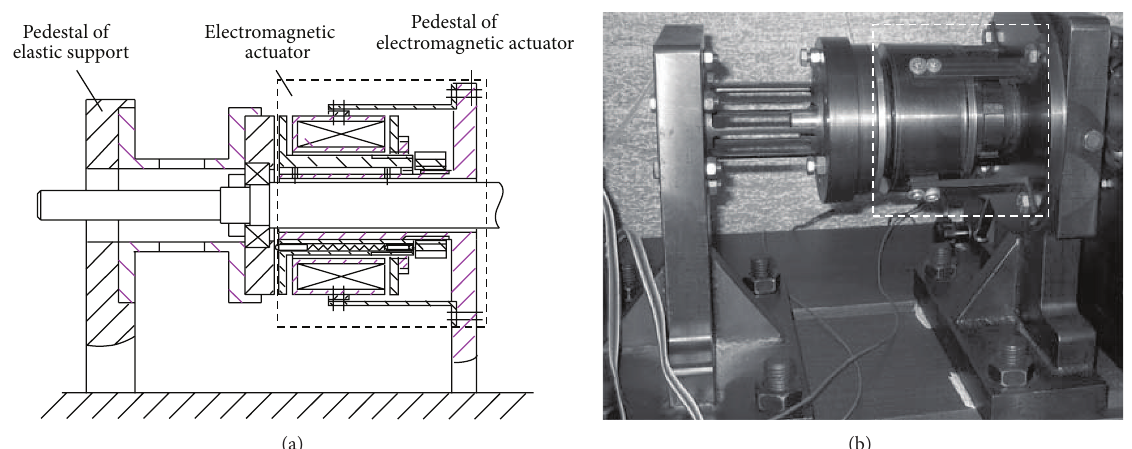
Figure 8: The active elastic support/dry friction damper with electromagnetic actuator.